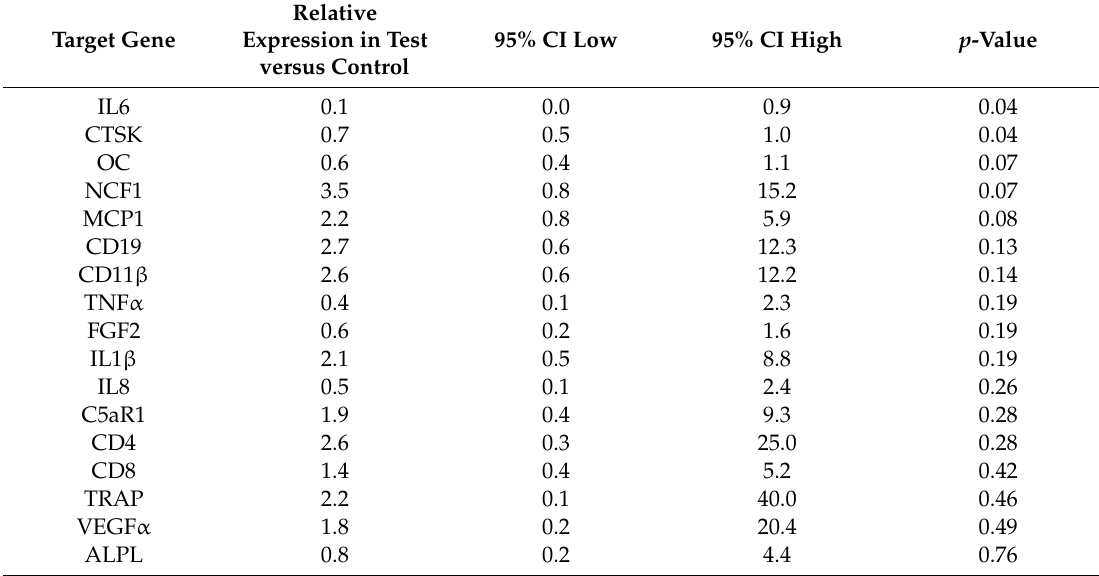
Figure 8. Up and down regulation of the selected markers in the soft tissues around implants with silk ligatures versus controls (no ligature). Table 3. Relative expression of the selected gene targets in the bone around implants with silk ligature versus the bone around controls (no ligature).